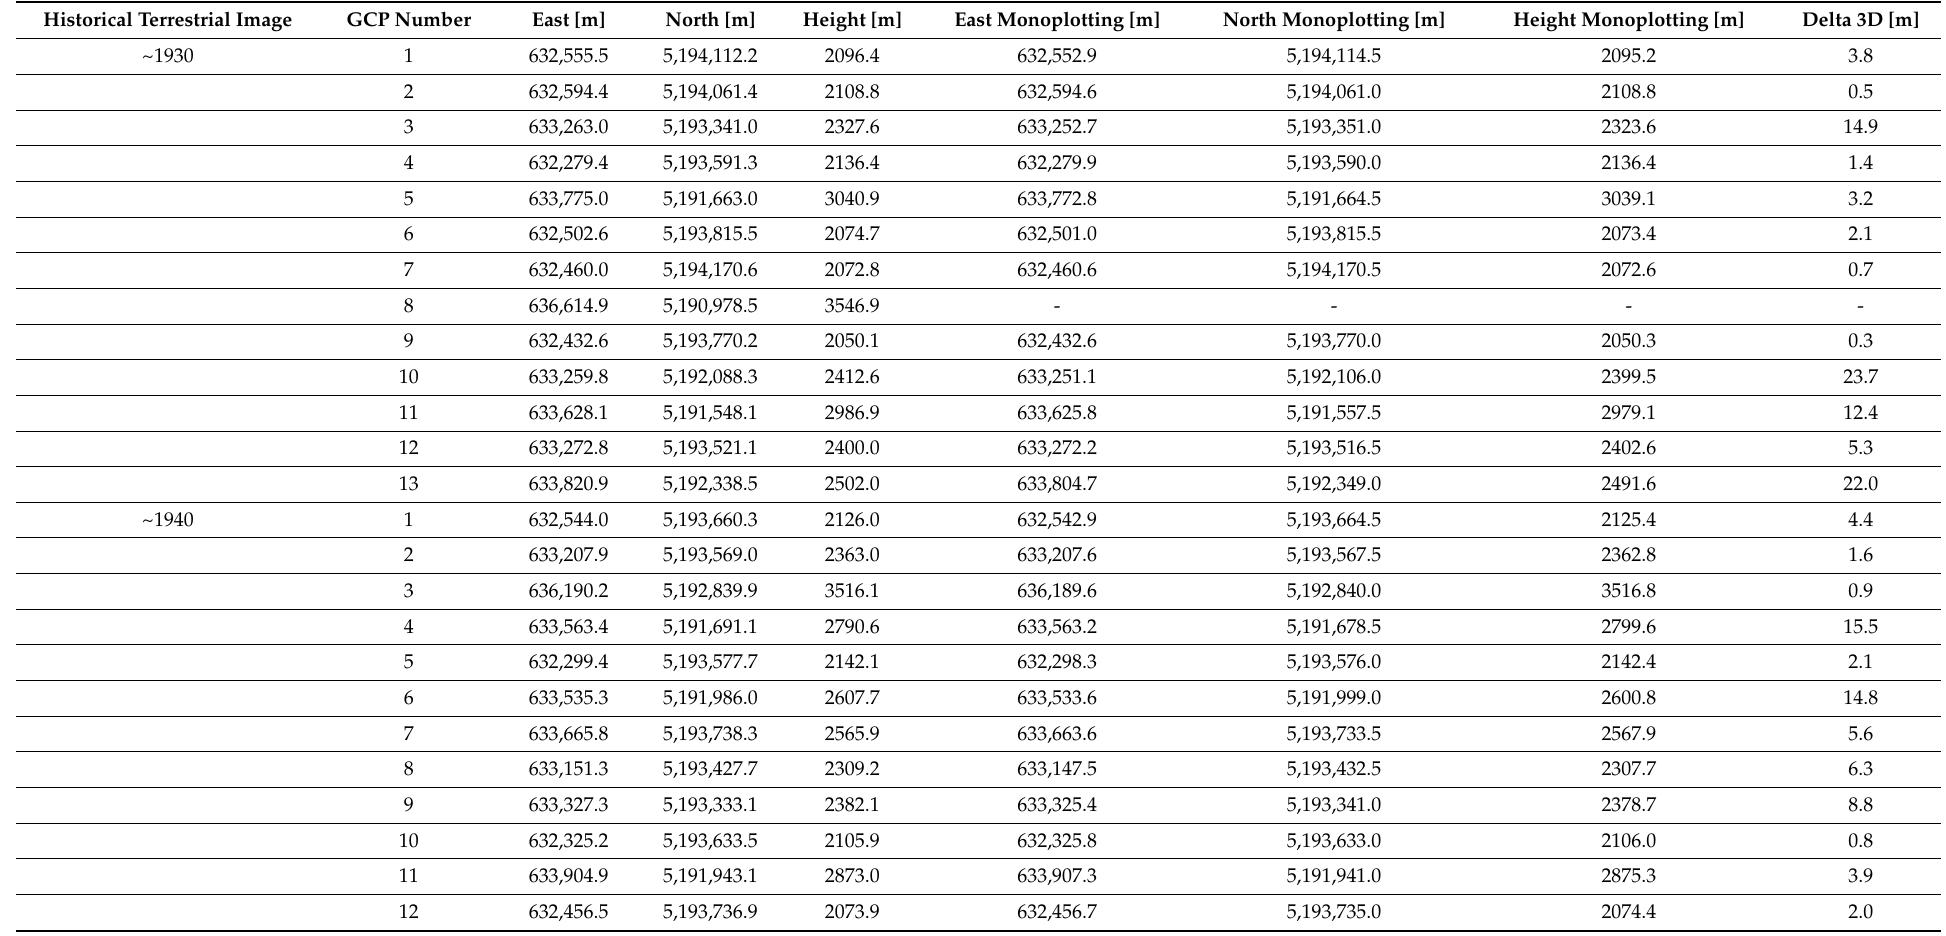
Table A4. Monoplotting accuracy of ~1930 and ~1940 photos: Coordinates of the user defined GCPs (East, North and Height), by monoplotting calculated GCPs (East monoplotting, North monoplotting and Height monoplotting) and corresponding Euclidean distance as error value (Delta 3D). In two cases, no coordinates could be determined using monoplotting. Used coordinate system: ETRS89/UTM Zone 32N coordinate system (EPSG code: